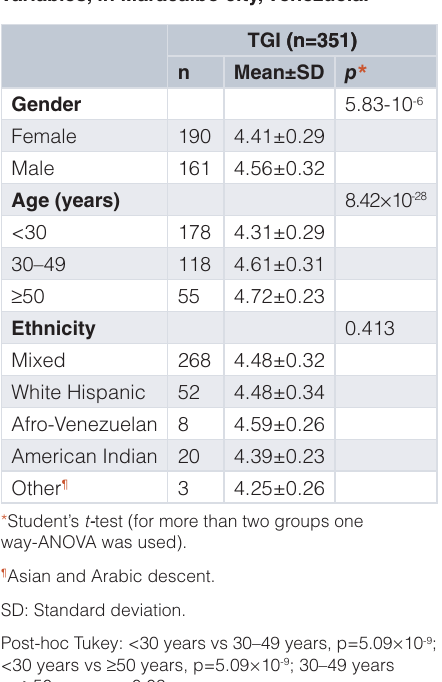
Table 2. Epidemiological behavior of the triglyceride-glucose index in the general population according to sociodemographic variables, in Maracaibo city, Venezuela.